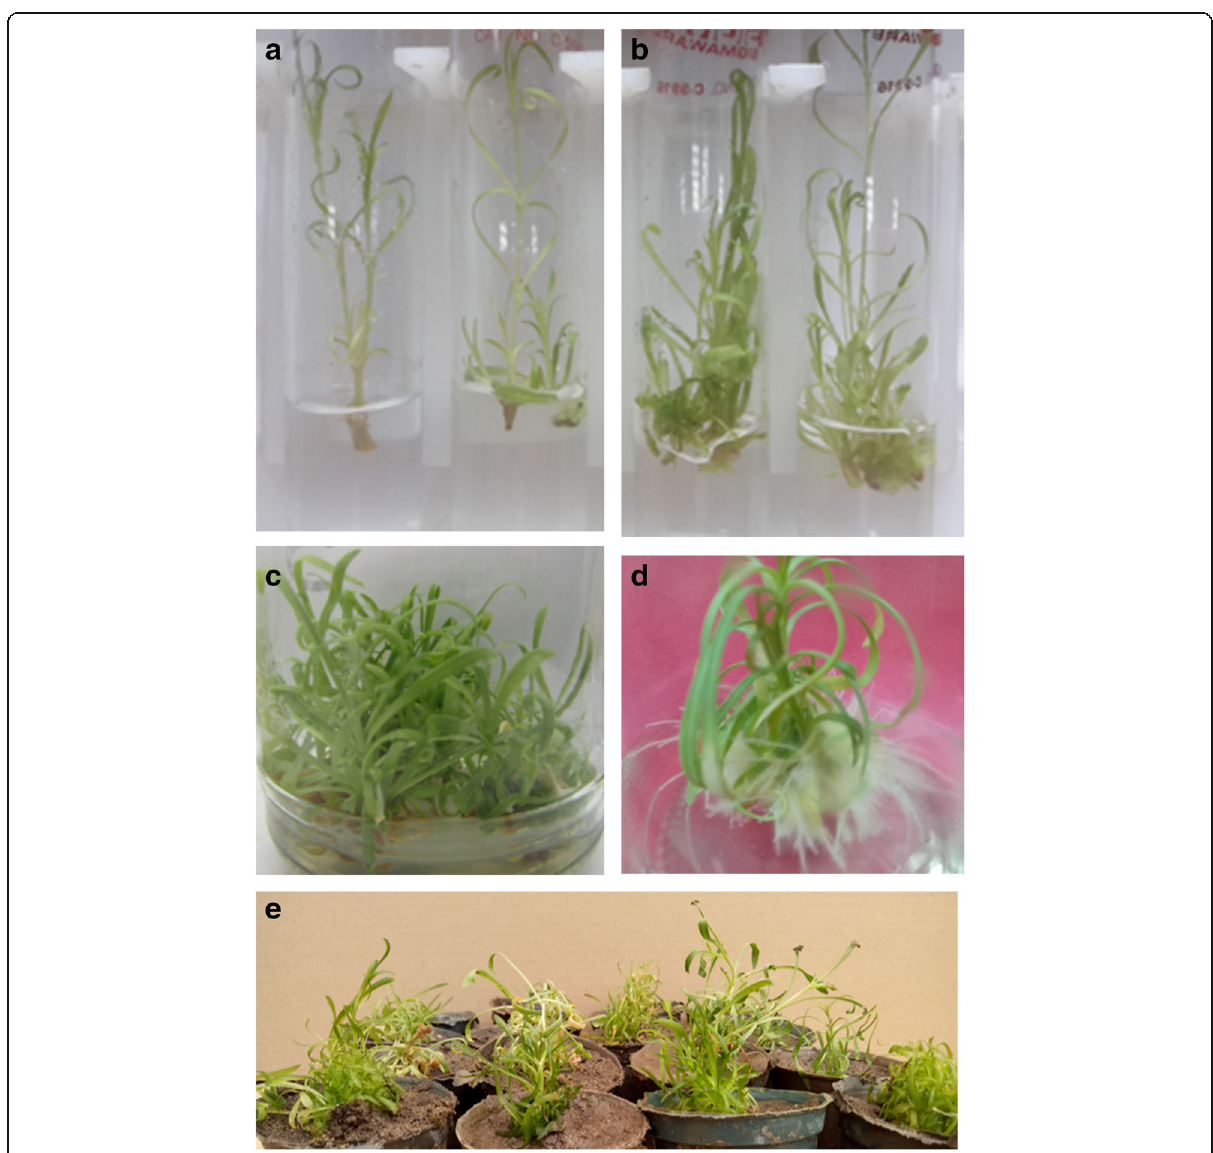
Fig. 3 In vitro propagation of Silene schimperiana ; ( a ) in vitro establishment of shoot tip, ( b ) in vitro establishment of stem nodal segment, ( c ) multiplication of axillary shoots, ( d ) rooted plantlet, and ( e ) acclimatization of transplants in the